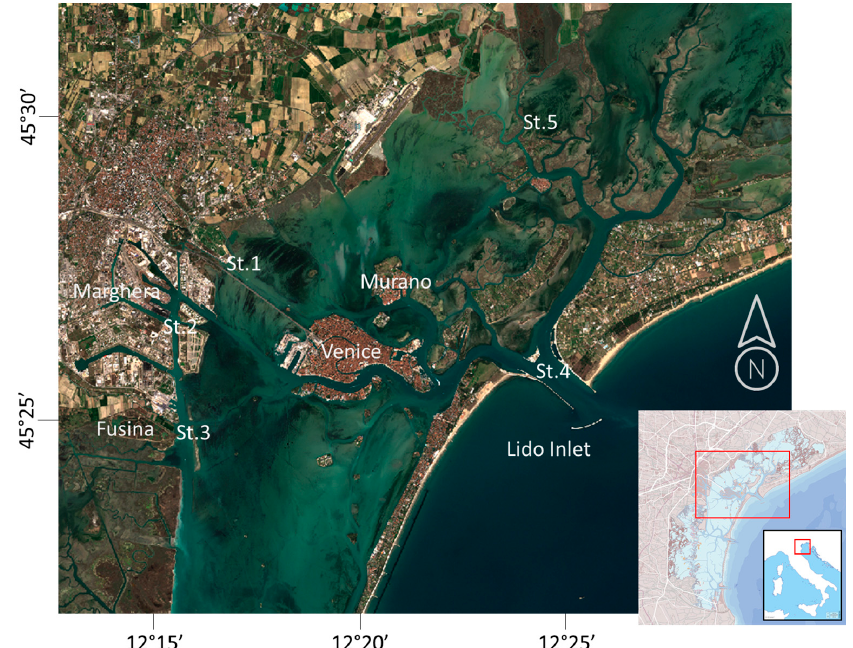
Figure 1. The Lagoon of Venice and the location of the five sampling stations. The location of the towns of Venice and of the industrial areas of Fusina and Marghera is also evidenced.